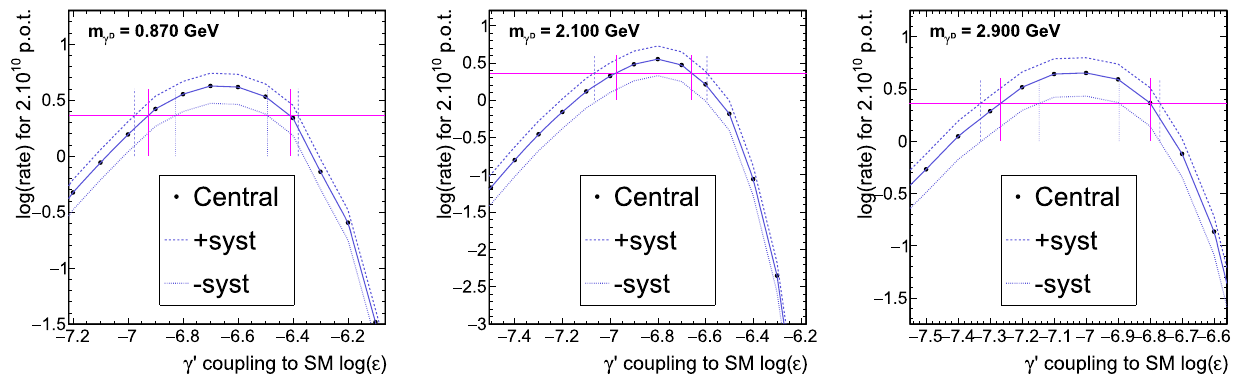
Fig. 12 Expected rate as a function of ε , for m γ D = 0 . 87 (left), 2.1 (middle) or 2.9 (right) GeV and meson, proton bremsstrahlung with dipole form factor or QCD production, respectively. The horizontal pink line shows the 2.3 events threshold used to set the limit. Vertical Fig. 13 Expected 90% exclusion region as a function of the dark photon mass and of the kinetic mixing parameter ε 2 , for the three production modes studied (top), and their combinations for the two proton bremsstrahlung scenarios (bottom). The dashed lines highlight the 1- σ uncertainty band using the systematics described in Sect. 4.4. The excluded region in grey is from Ref.